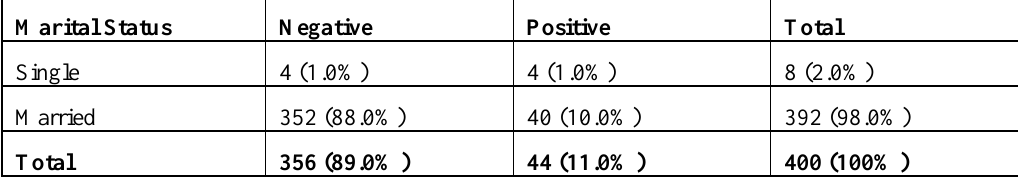
Table 5. Association between marital status and hepatitis B status among pregnant women in Ilorin.